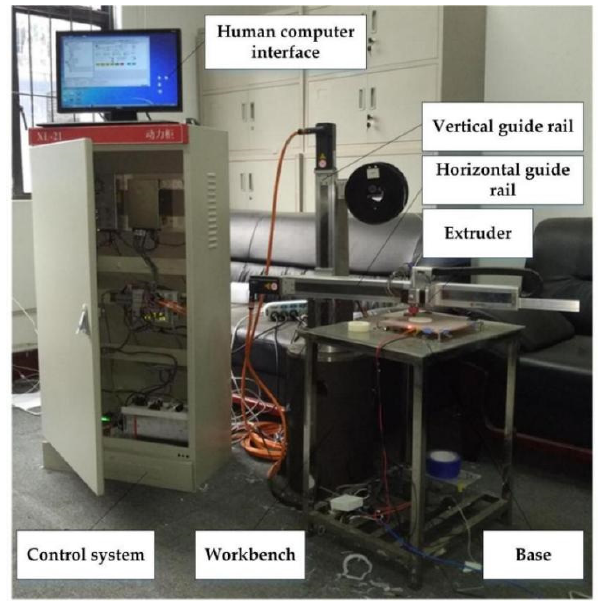
Figure 6. The cantilever AM platform.